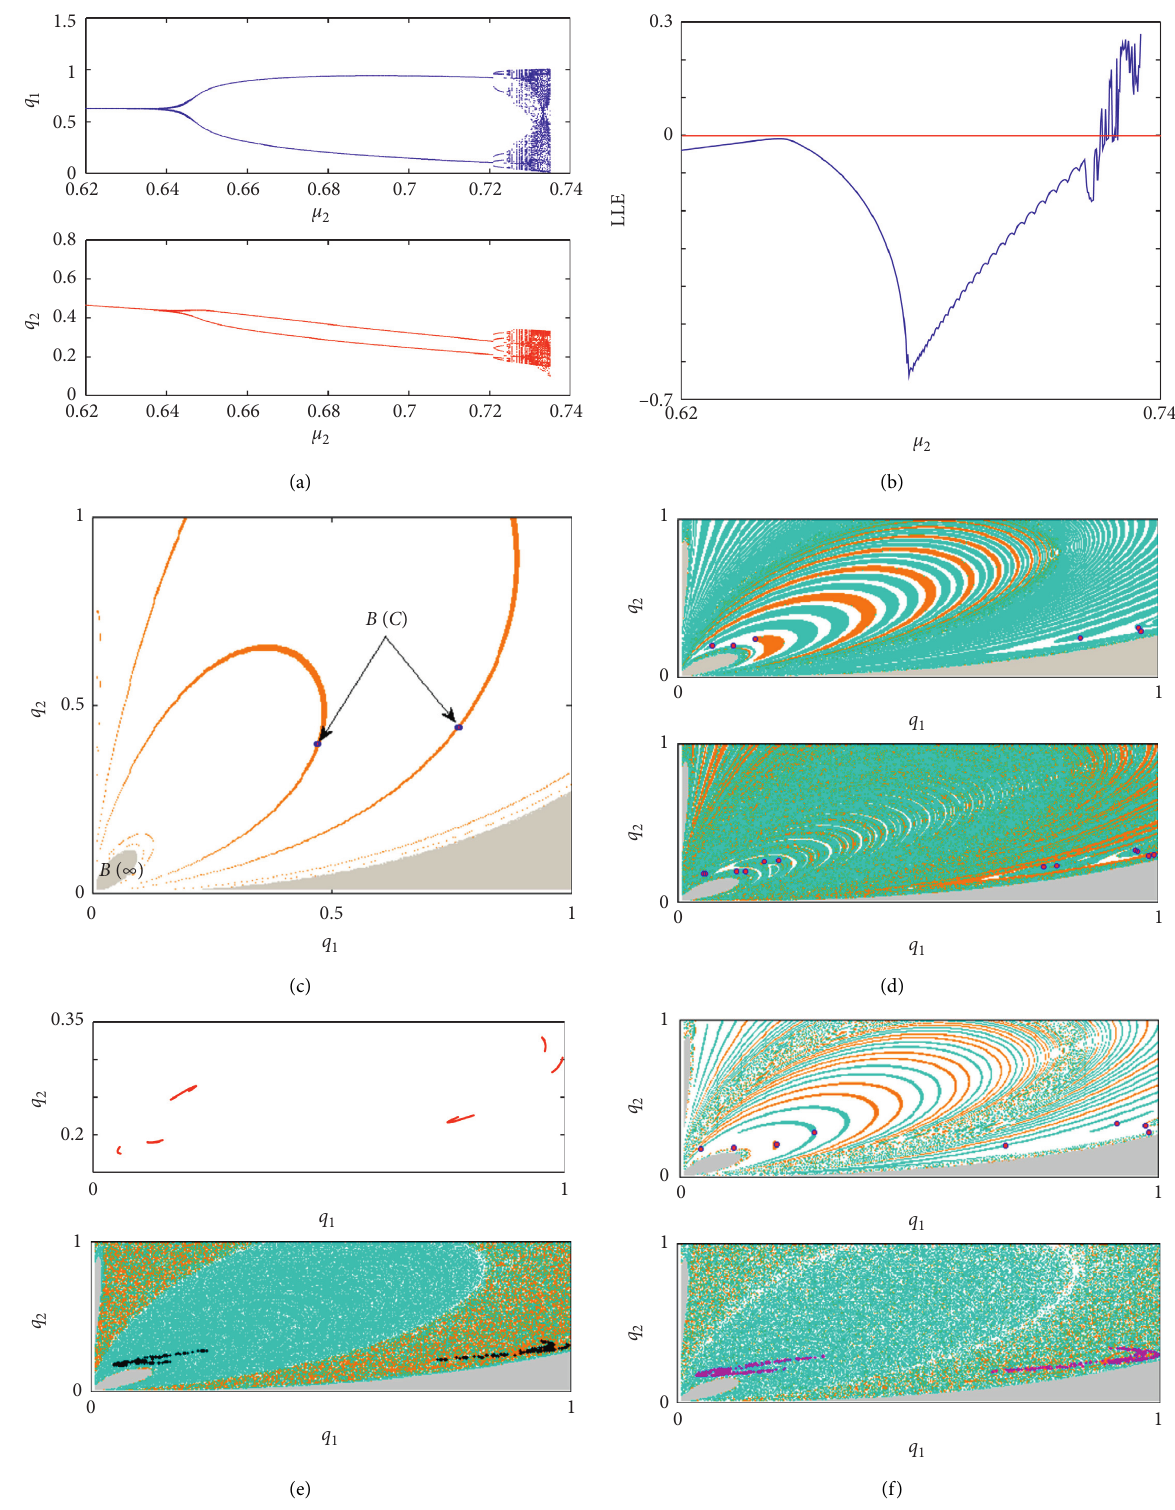
Figure 4: The fixed parameter values are c � 0 . 35 ,c � 0 . 2 , μ � 0 . 1, and α � 5. (a) Bifurcation diagrams of q 1 2 1 . (b) Largest Lyapunov exponent with respect to μ . (c) Basin of attraction of the period 2-cycle at μ � 0 . 648. (d) Basin of parameter μ 2 2 � 0 . 721 and μ � 0 . 7245, respectively. (e) The phase plane of the six pieces chaotic attraction of the periods 6-cycle and 12-cycle at μ 2 2 � 0 . 725 and the basin of attraction of the chaotic behavior converted to a period 2-cycle at μ attractors at μ 2 � 0 . 7259 and the chaotic behavior converted to two spirals at μ attraction of period 8-cycle at μ 2